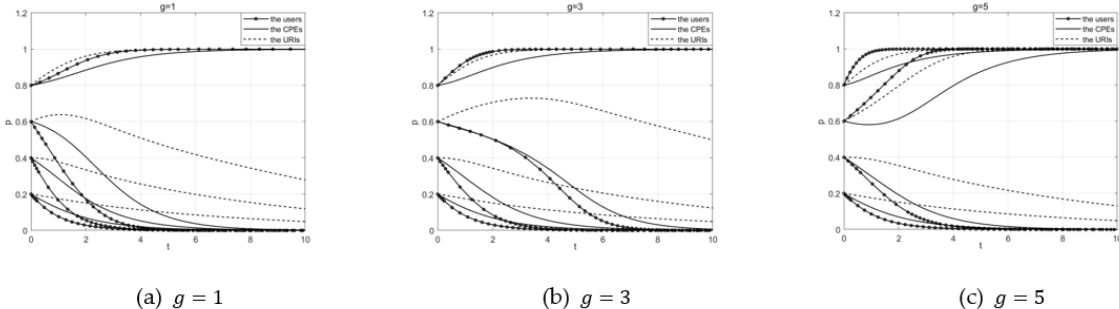
Figure 2. Impact of government support on the strategies of the Users, the CPEs and the URIs, and ( a – c ) show the evolution of the tripartite strategies under different values of g .